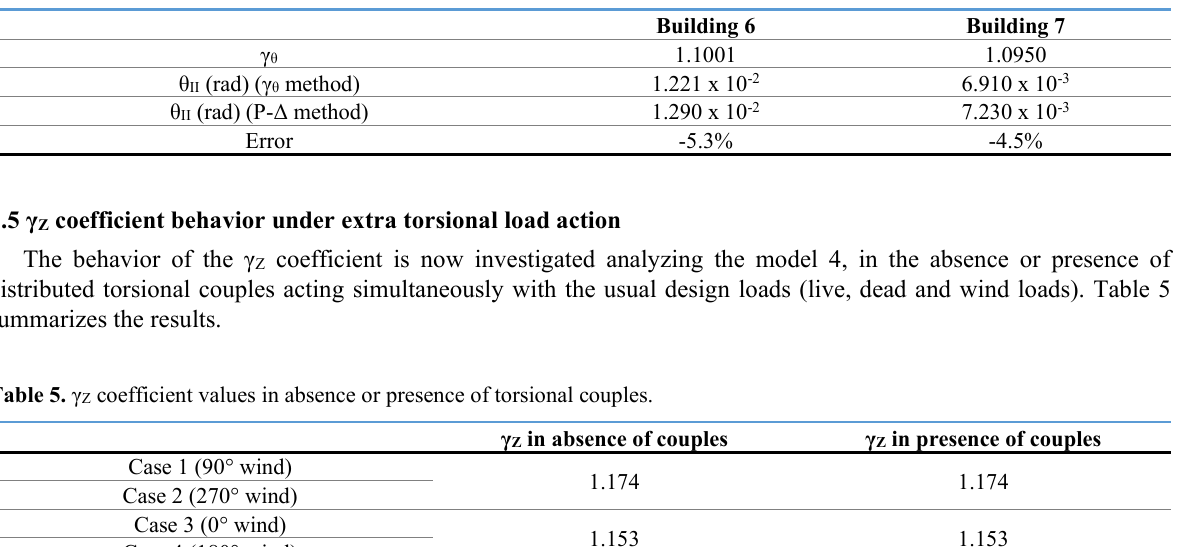
Table 4. γ θ coefficient calculation and comparison with P- Δ method (irregular buildings).